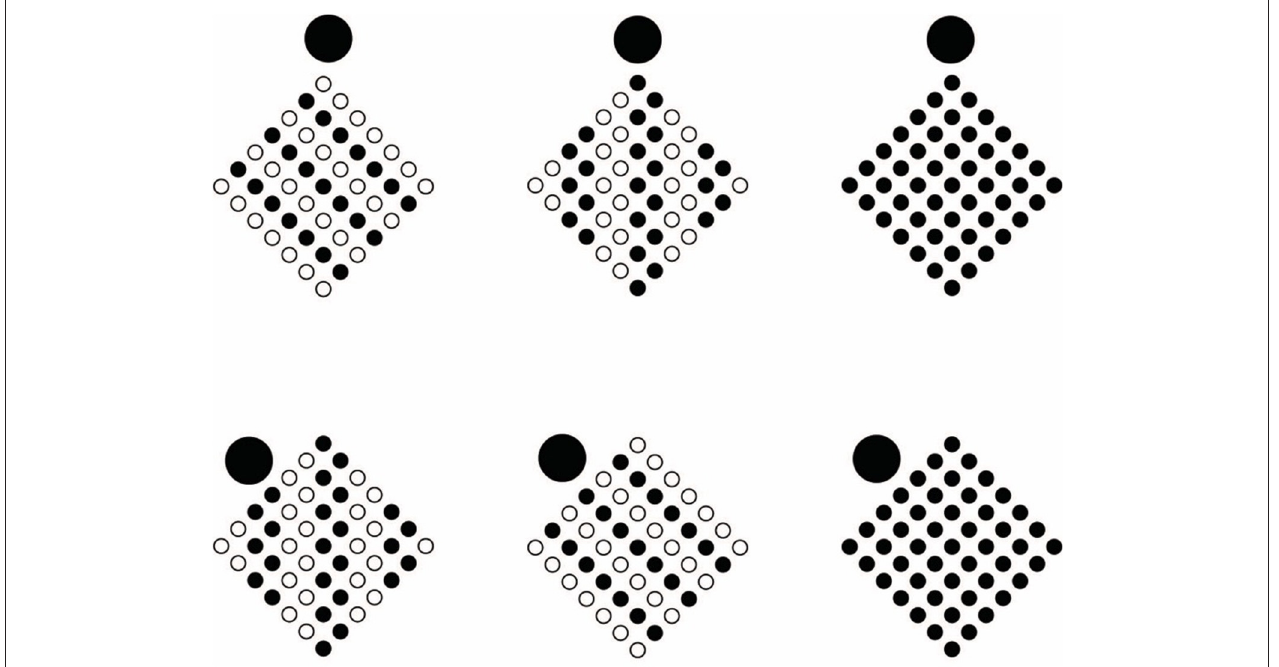
FIGURE 11 | Similarity principle pitted against Accentuation